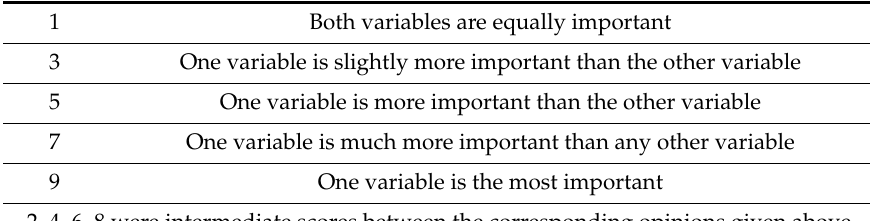
Table 5. The assessment criteria [78].